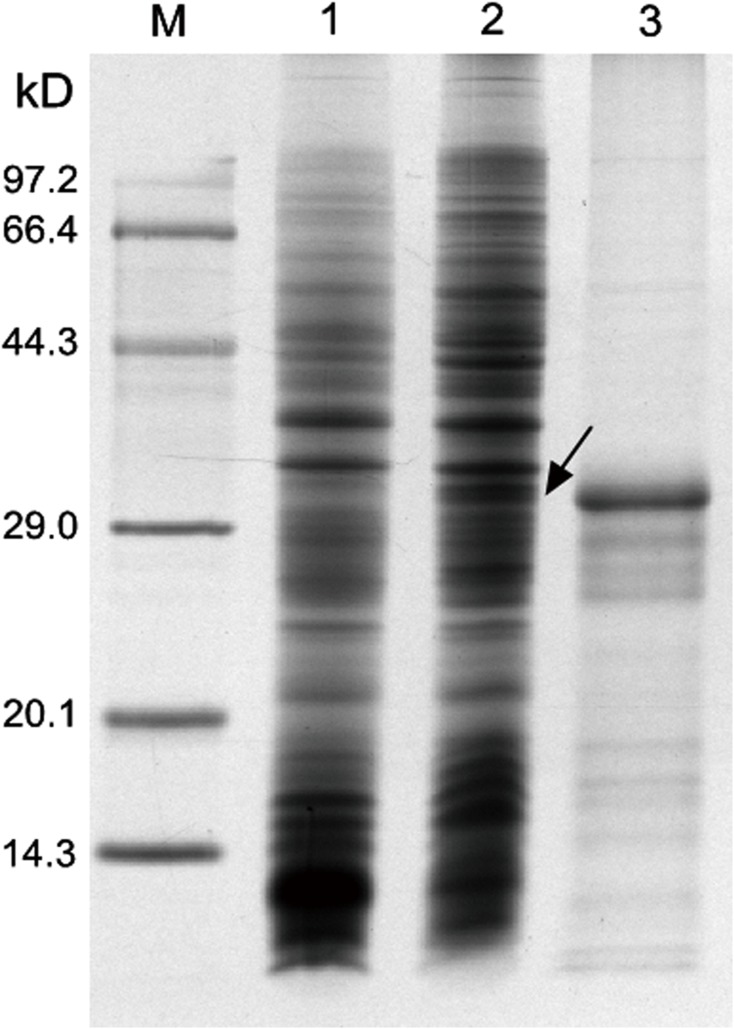
Prokaryotic expression analysis of the recombinant protein EhaF on SDS-PAGE.The recombinant protein was induced with 0.2% ɑ-lactose at 30°C for 16 h. Lanes 1: induced whole-cell harboring pET 30a (+) lysate; Lanes 2: induced whole-cell harboring pET 30a (+)-mru1407 lysate; Lanes3: purified protein after concentrated. The arrowhead points out the position of target protein.